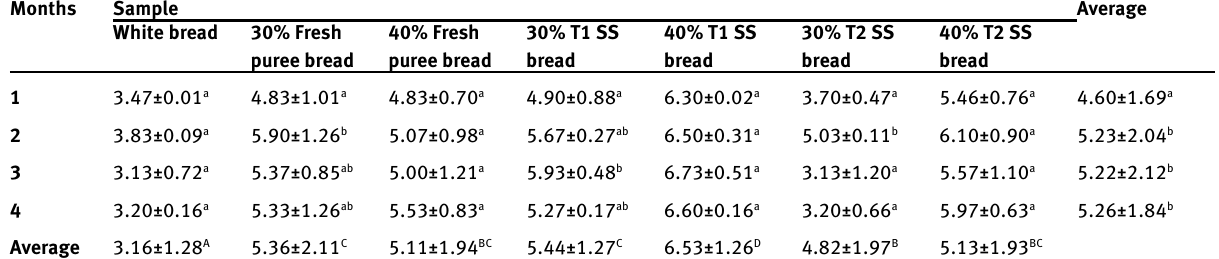
Table 4: Sensory Scores for